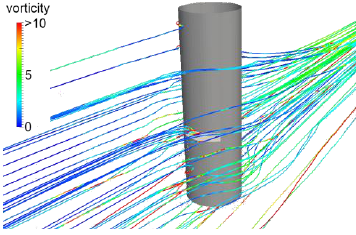
Figure 3. Streamlines around the sensor probe.